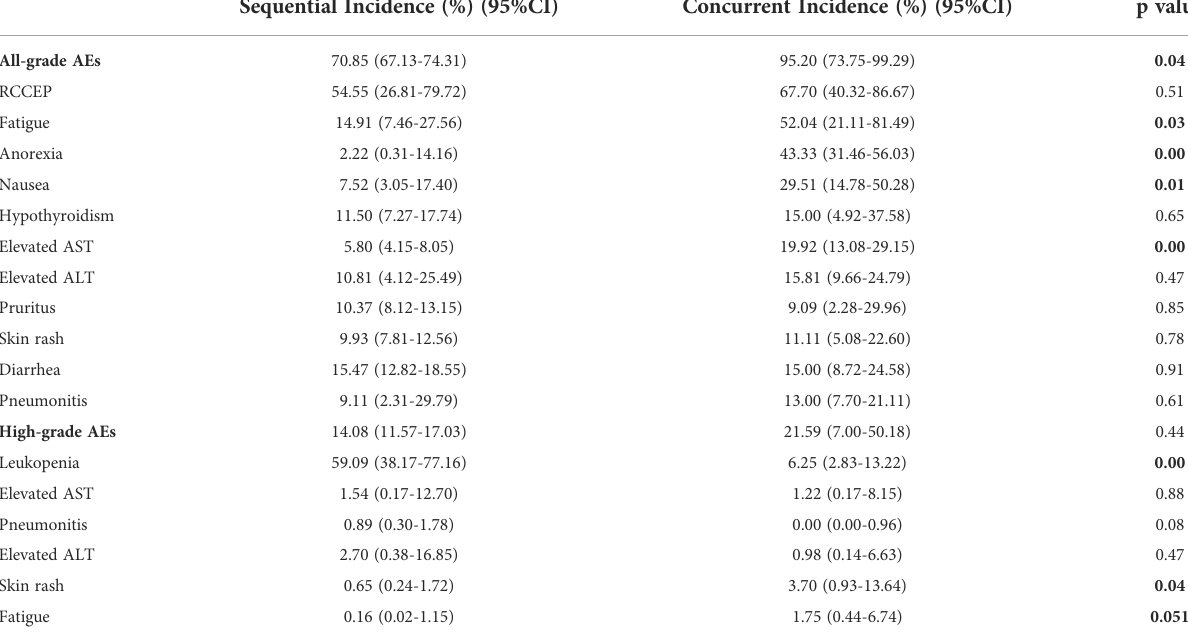
TABLE 4 Differences in the incidence of AEs with concurrent vs sequential ICIs combined with TRT.